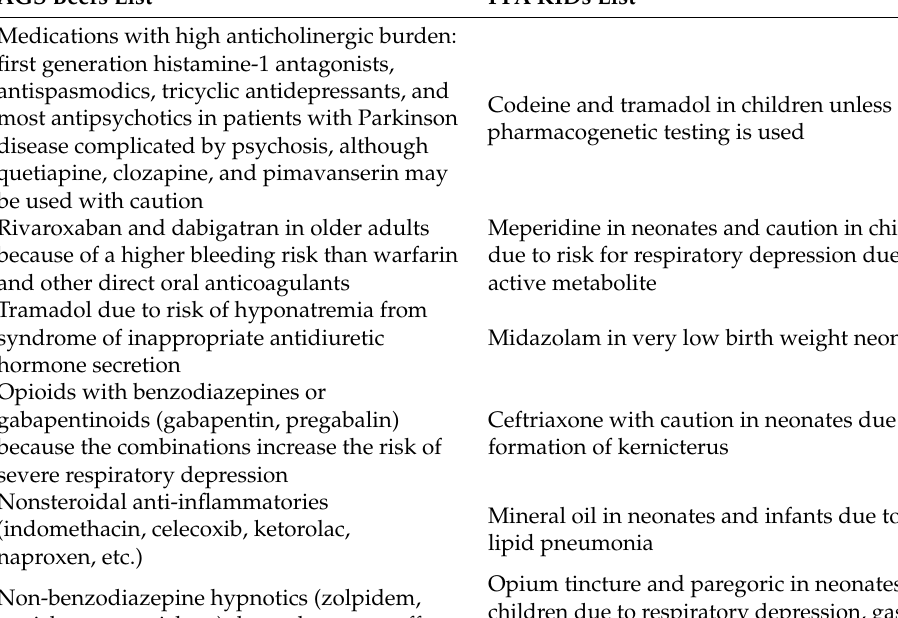
Table 4. AGS Beers and KIDs Listed Medications and Classes with Greater Risk to Benefit. AGS Beers